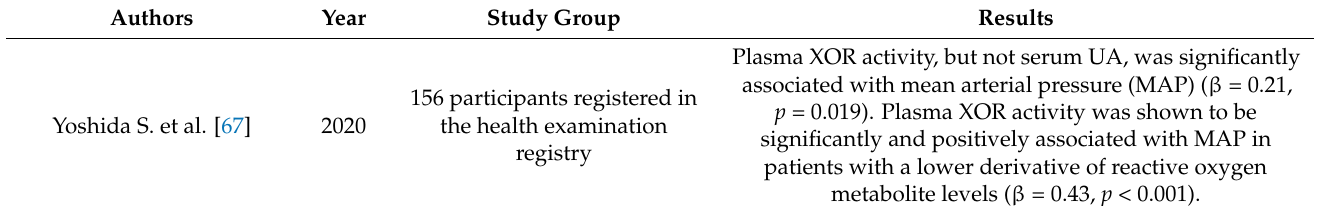
Table 2. Summary of the studies discussed in the general